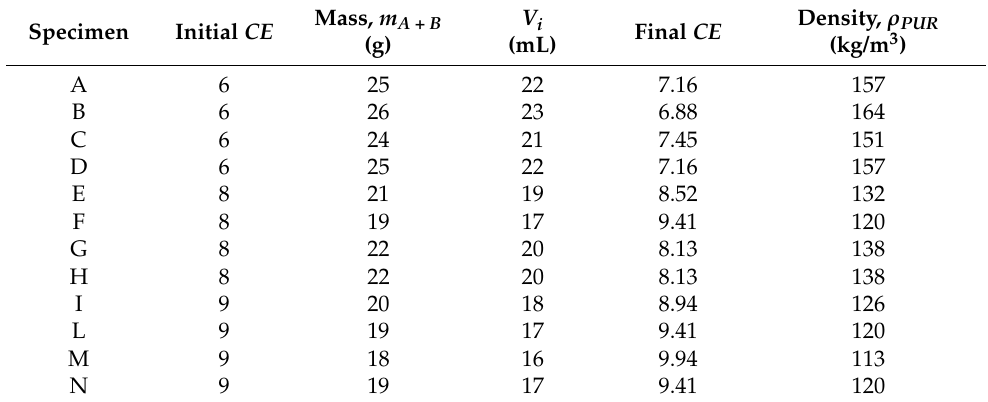
Table 1. Summary of the polyurethane specimens with related properties.